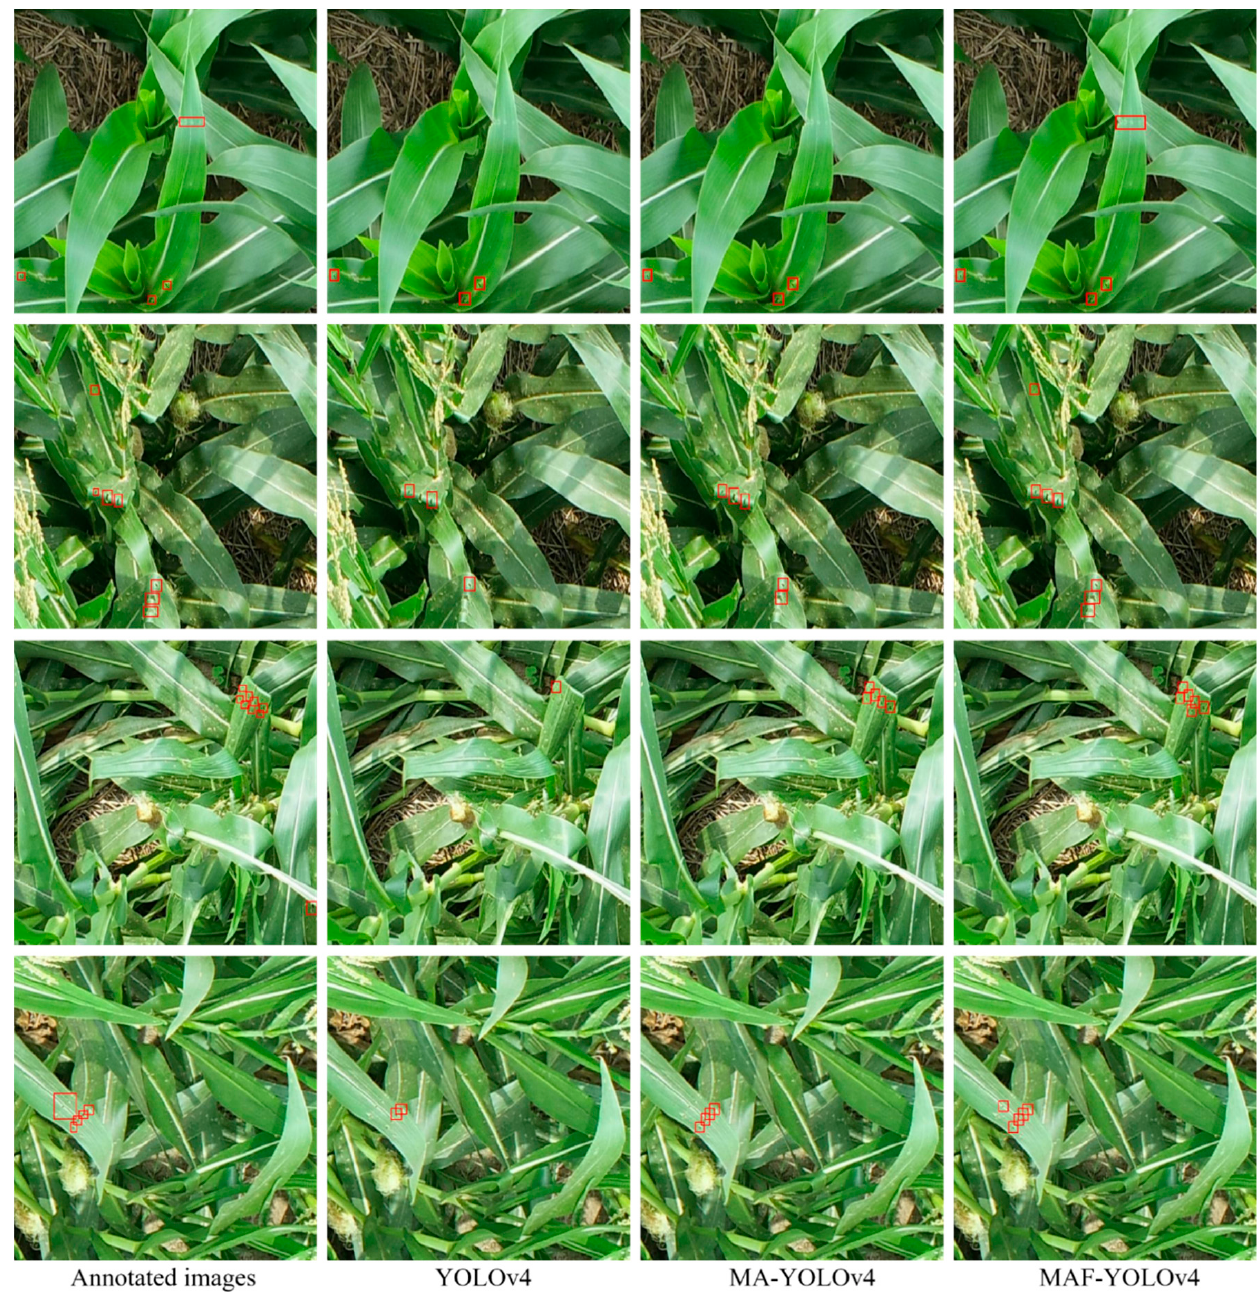
Figure 12. Annotated images and detection results; The first row belongs to DV12, the rest belong to DVT.